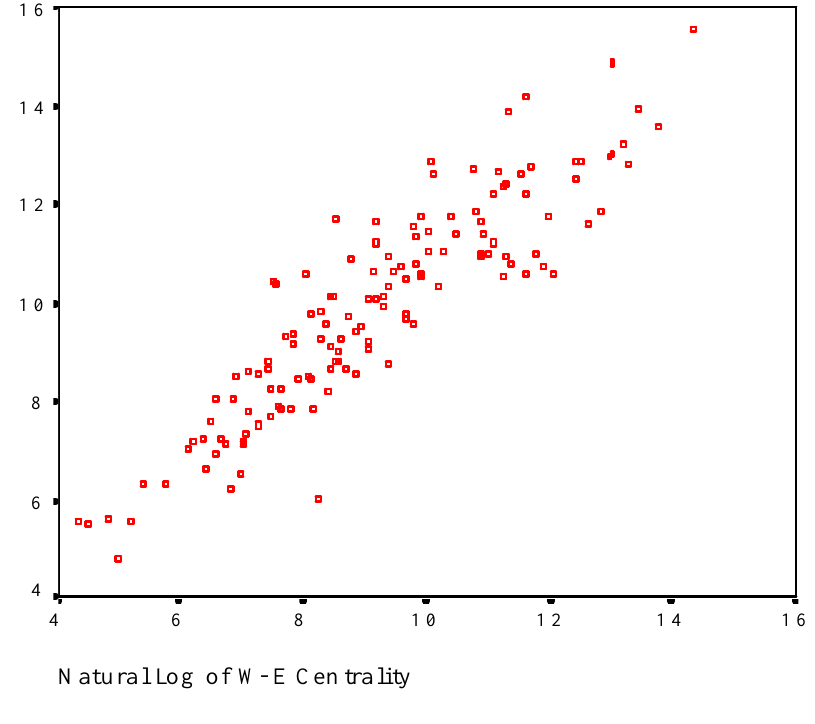
Figure 1. Scatterplot of Carbon Dioxide Emissions (LN) by World-Economy Centrality